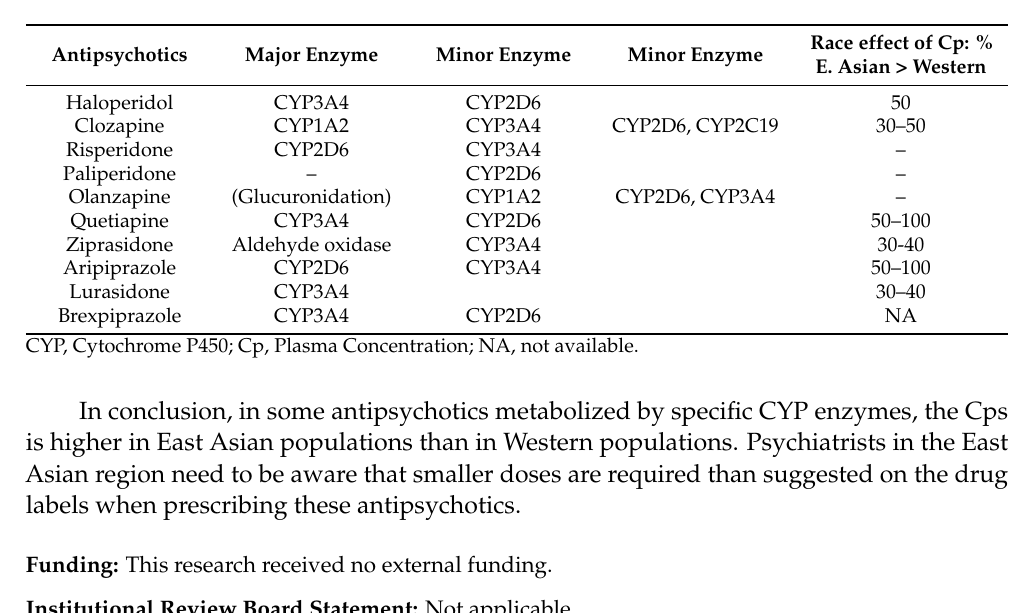
Table 2. Cytochrome P450 enzyme system responsible for antipsychotic metabolism and the effects of